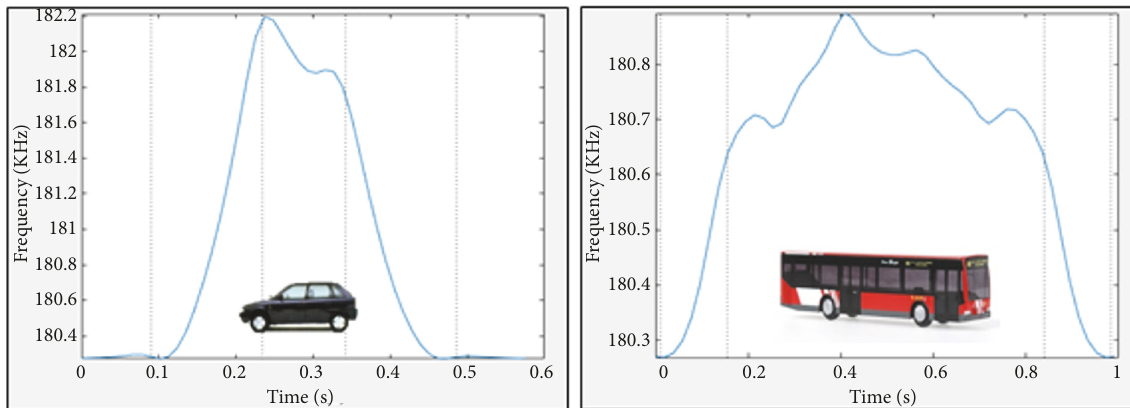
Figure 3: Magnetic profiles. (a) Car. (b) Bus.